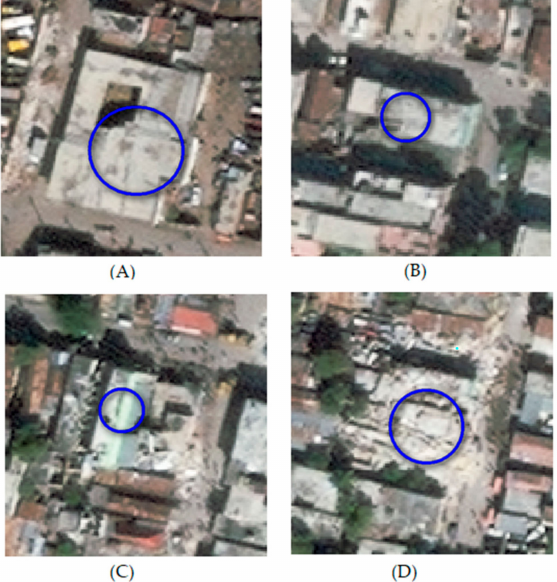
Figure 2. Examples of damaged buildings caused by the Haiti earthquake. ( A ) Grade 1; ( B ) Grade 3; ( C ) Grade 4; ( D ) Grade 5. Grade 2 was not presented in the